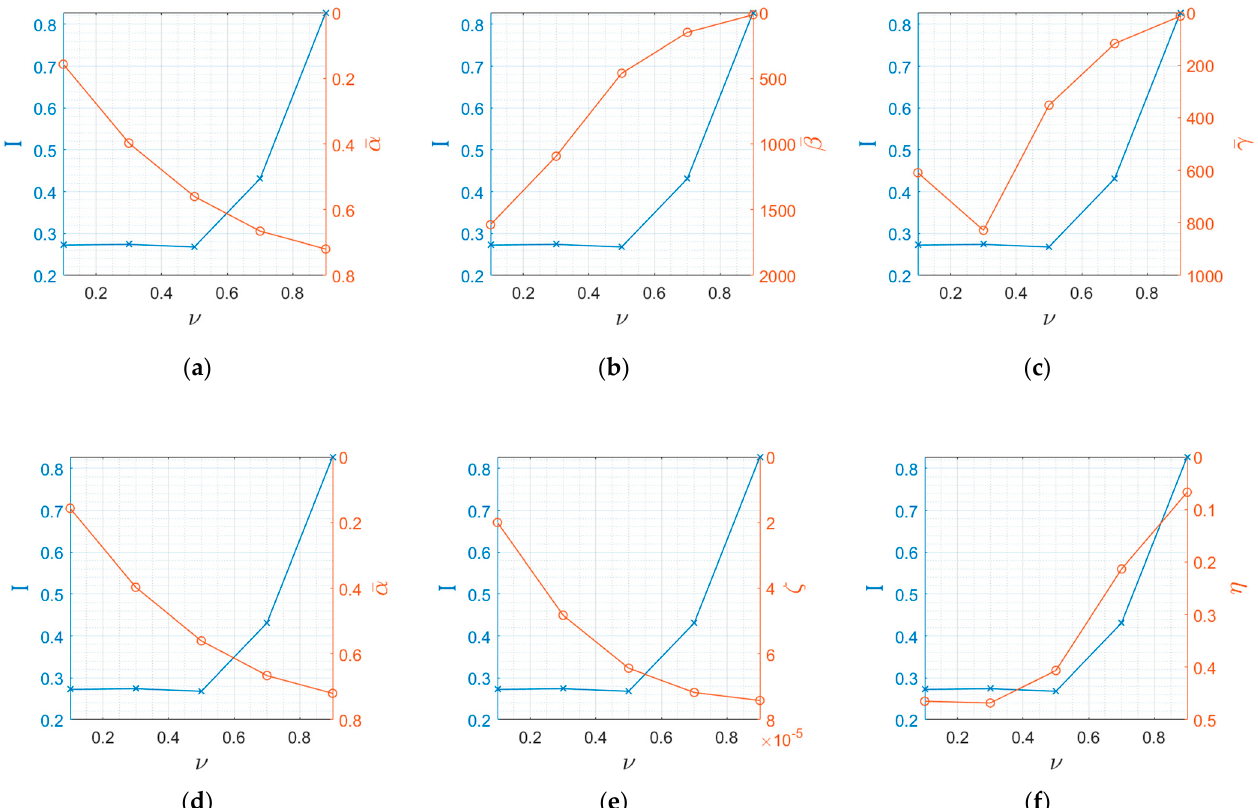
Figure 8. Comparison between d-EIs (the first row) and c-EIs (the second). The indicators are ( a ) streamline crossing; ( b ) shear rate; ( c ) the product of the streamline crossing and shear rate; ( d ) streamline crossing; ( e ) the relative rate of velocity change; and ( f ) mobility.